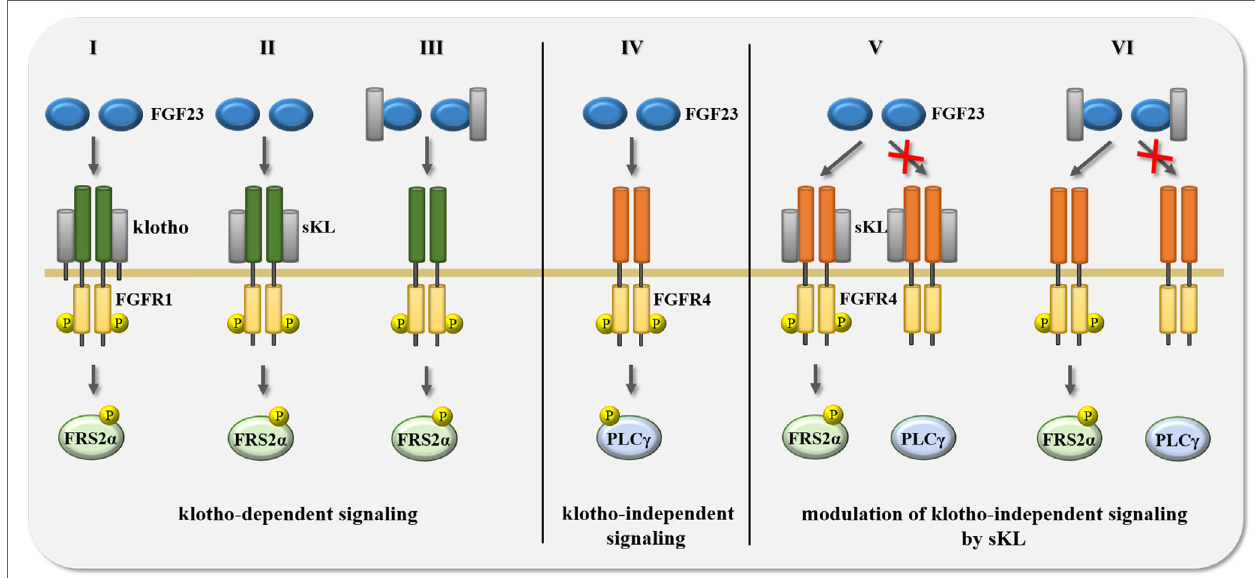
FiGURe 3 | Summary of potential scenarios for the crosstalk between FGF23 and klotho in the regulation of signal transduction. FGF23-activated signaling events are mediated and modified by the availability of either membrane-associated full-length klotho or soluble klotho (sKL). (I–III) Transmembrane klotho as well as sKL mediate FGF23 binding to FGFR1 resulting in the phosphorylation of FGF receptor substrate 2 α (FRS2 α ) and the subsequent activation of Ras/mitogen-activated protein kinase (MAPK) signaling. (IV) In the absence of klotho and sKL, FGF23 binds FGFR4 which induces the phosphorylation of phospholipase C γ (PLC γ ) and the activation of calcium-regulated signal pathways, such as calcineurin/NFAT. (V–VI) Membrane-associated klotho and sKL can modulate klotho-independent FGF23/FGFR4 signaling in two different ways. First, in the presence of klotho or sKL, FGF23 cannot bind to FGFR4, and thereby not activate the PLC γ -driven signaling cascade. Second, binding of FGF23 to FGFR4 can also occur in the presence of transmembrane klotho or sKL, but causes different downstream events, switching from PLC γ to FRS2 α phosphorylation, thereby activating Ras/MAPK instead of calcineurin/NFAT signaling. Abbreviation: P, protein